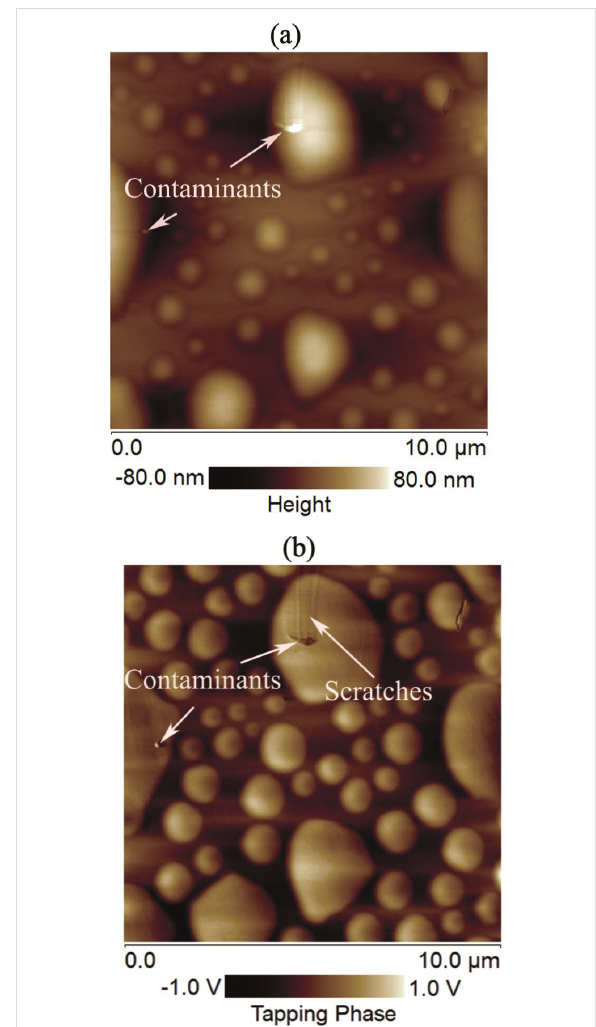
Figure 9: AFM topographic and phase images of PS-coated surfaces obtained in air and water. (a,b) Topographic and phase images, re- spectively, of the PS-coated surface obtained in DI water. The unknown objects as well as the scratches are clearly visible on the domains. Additional images are given in Supporting Information File 1, Figure